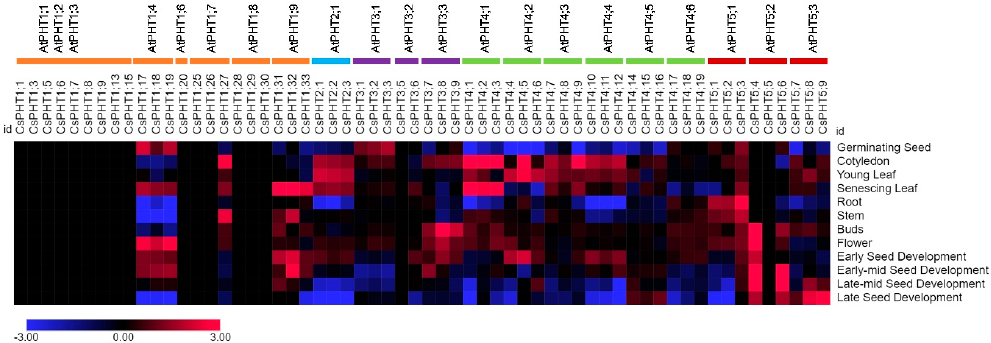
Figure 5. Expression pattern of CsPHT genes in 12 different tissues covering four developmental stages. The Arabidopsis PHT orthologs were shown on the top. The RNA-seq data (Log2 Ratio) were extracted from Camelina eFP browser (http://bar.utoronto.ca/efp_camelina/cgi-bin/efpWeb.cgi) [42], and the heatmap was generated using the MORPHEUS program (https: // software.broadinstitute.org / morpheus /